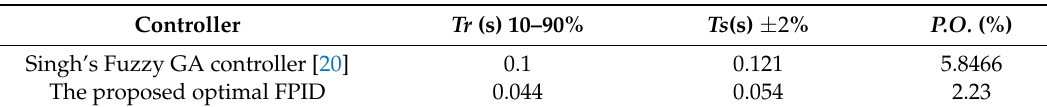
Table 5. Response performance of different controllers.